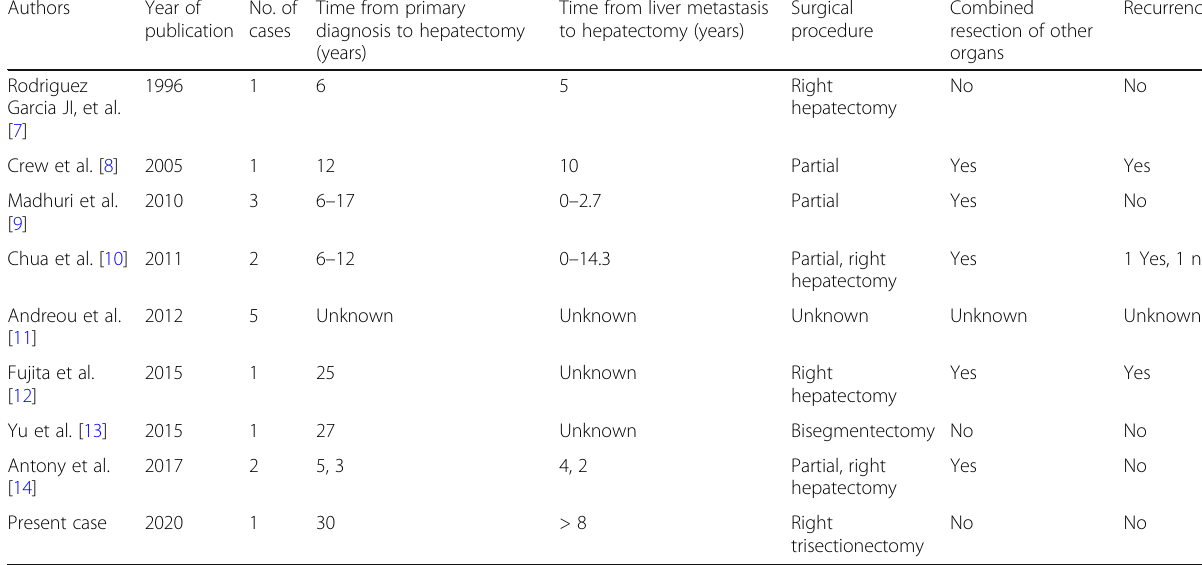
Table 2 Previous reports of patients with GCT liver metastasis who underwent surgical